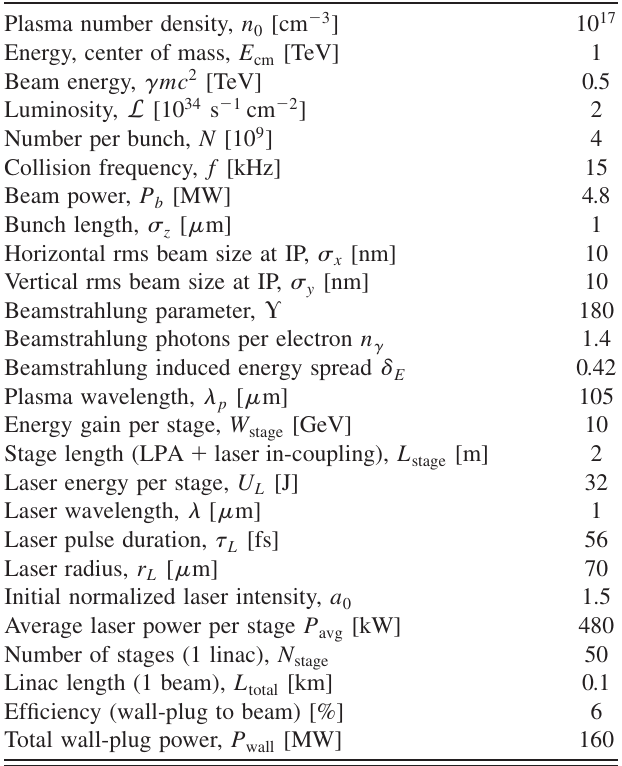
TABLE I. Example parameters for a 1 TeV laser-plasma linear